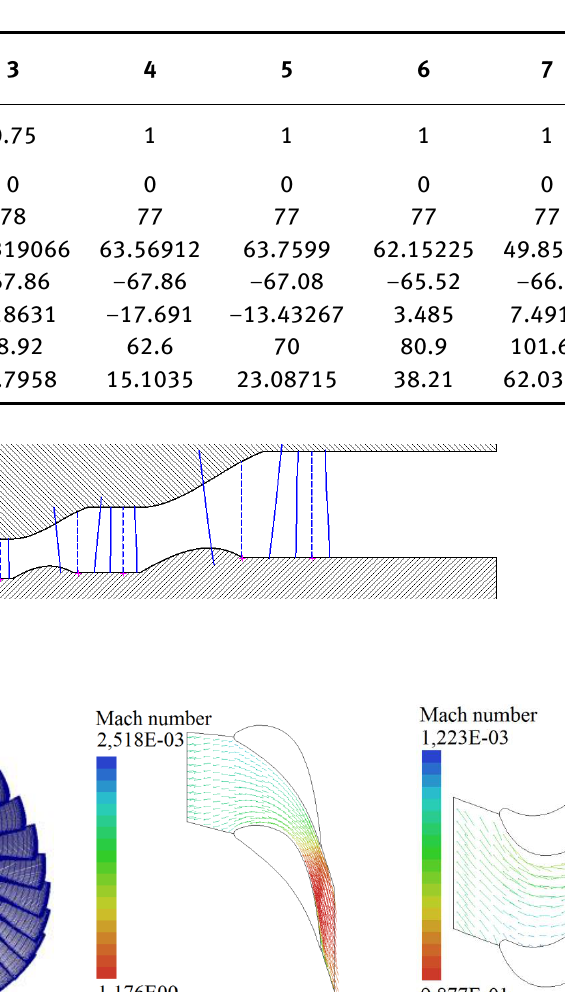
Table 2: Geometric characteristics of the blading system for turbine 2